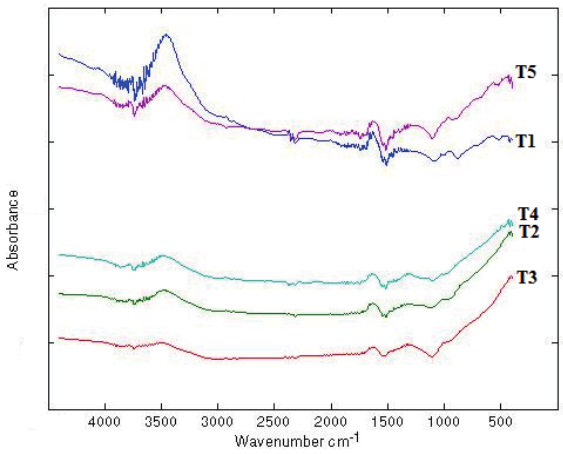
Figure 2 - FTIR spectrum from activated carbons T1 (non- treated) and T2, T3, T4 and T5 (treated).